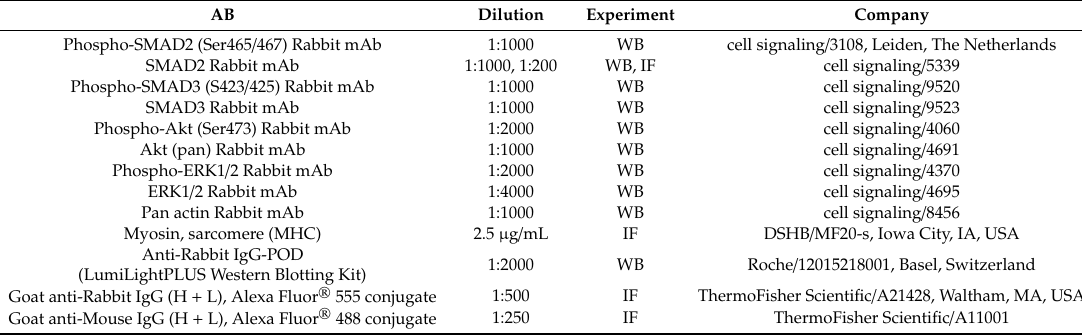
Table 2. Antibodies for Western Blotting and immunofluorescence. AB Dilution